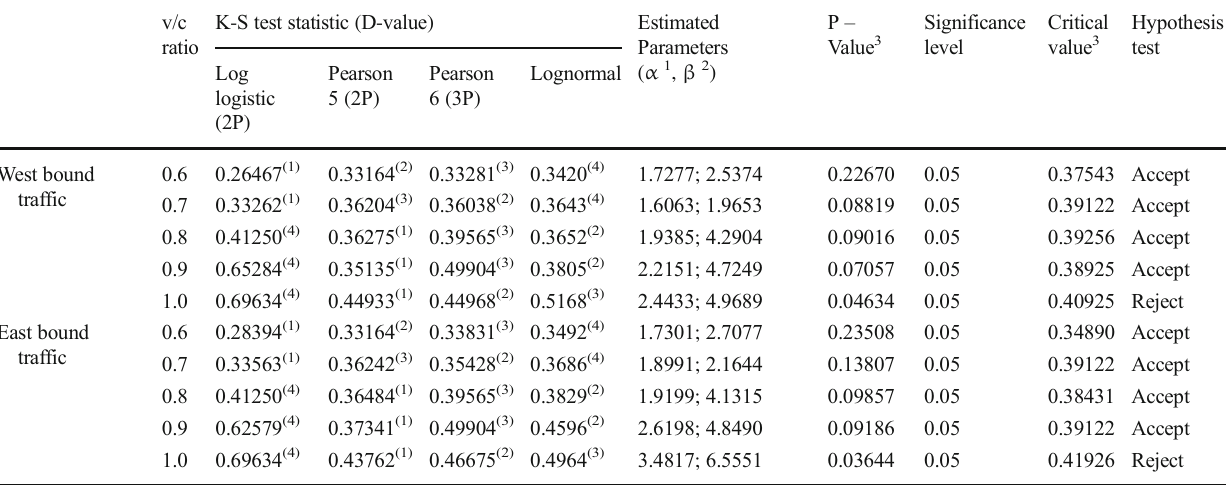
Goodness-of-fit test details and the estimated parameters of the fitted distribution model v/c K-S test statistic (D-value) ratio